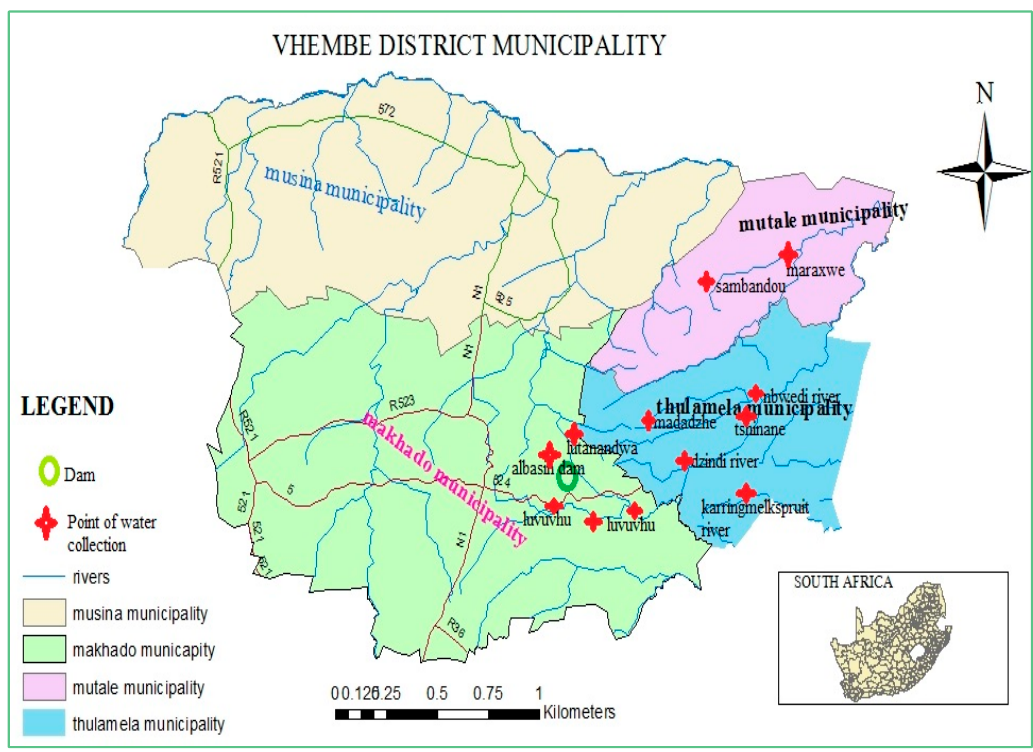
Figure 1. The Vhembe district municipality and sampling points in the Limpopo province, South Africa.